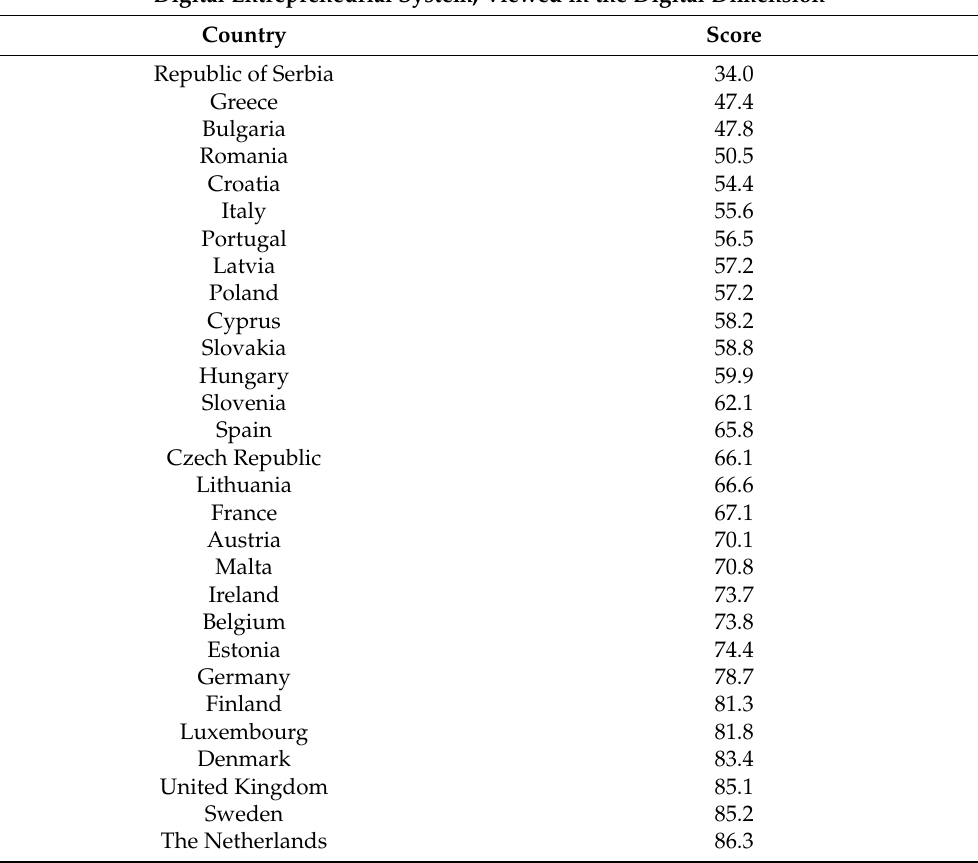
Table 12. Comparison of the Republic of Serbia and EU member states, based on the digital en- trepreneurial